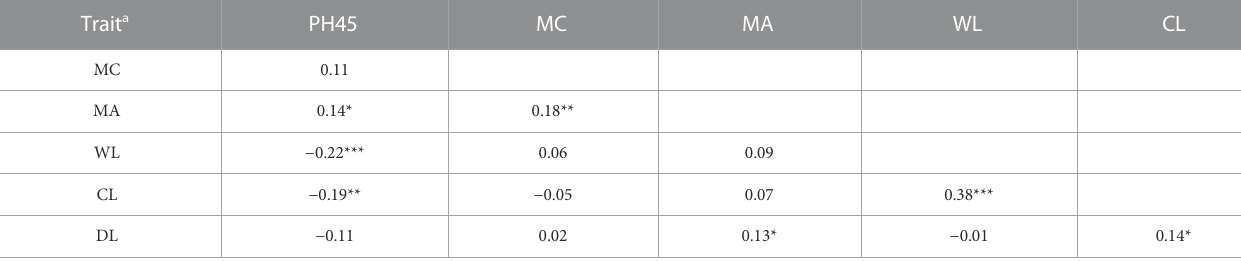
TABLE 2 Phenotypic correlations for six meat quality traits in crossbred pigs. Trait a